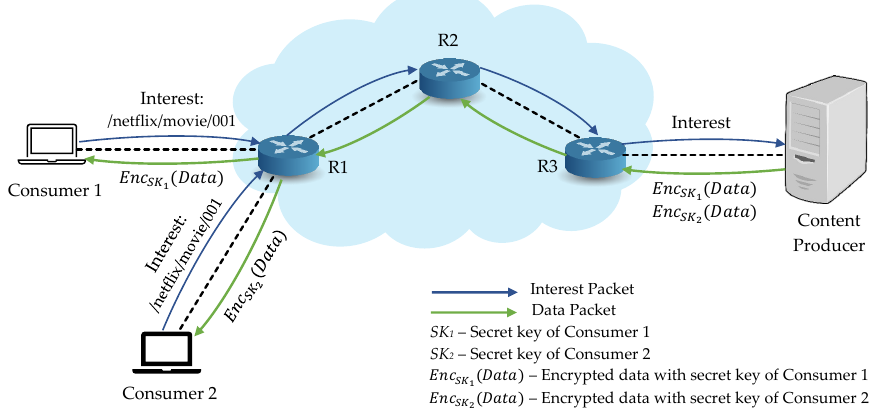
Figure 2. Encryption-based access control scheme in